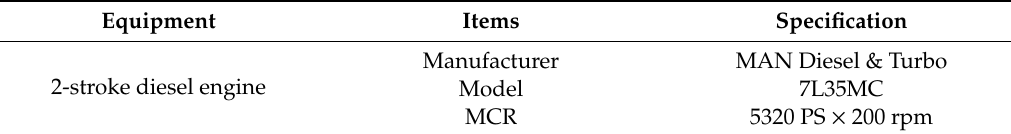
Table 3. Fuel oil